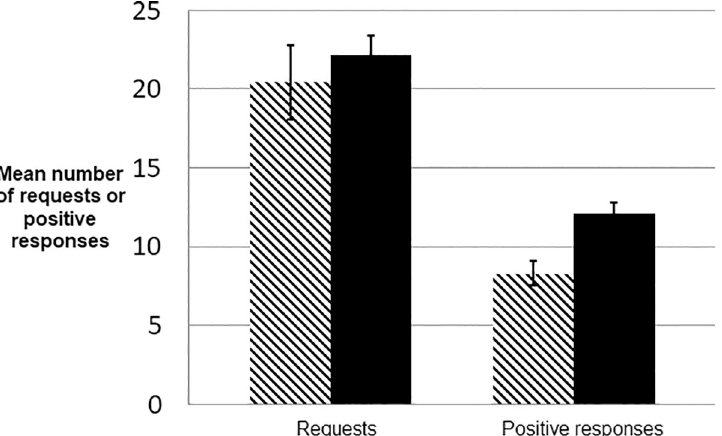
Fig 3. Requests and positive responses. Players in the primed condition (solid bars) made more requests and more often responded positively to requests than those in the control (hashed bars) condition. The difference in the number of times players made requests is not significant (t = -0.86; p (two-tailed) = 0.3936), but the difference in the number of times such requests were responded to positively was significant (t = -3.944; p (two-tailed) = 0.000), suggesting (as in Fig 2) that the priming texts may have had a larger effect on giving behavior than asking behavior. Error bars represent the standard errors of the means.